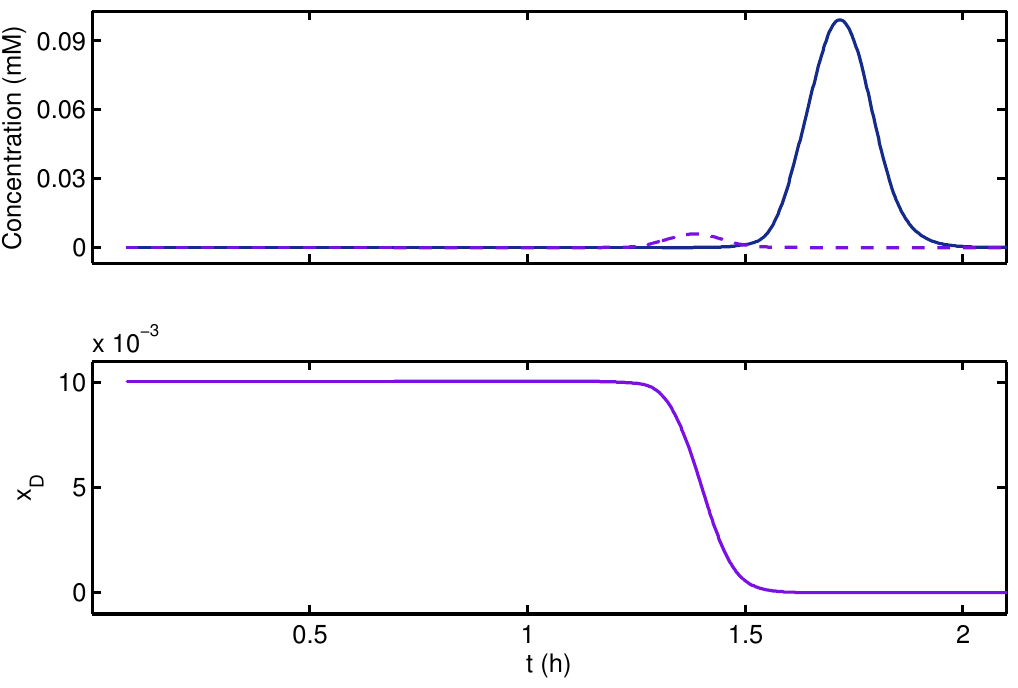
The top figure shows the simulated chromatogram during continuous virus inactivation. Solid line ( − ) is the monomers and dashed line ( −− ) is the ten times the dimers concentration. The bottom figure shows how x changes over time in the column. D As the dimers elute, x approached D